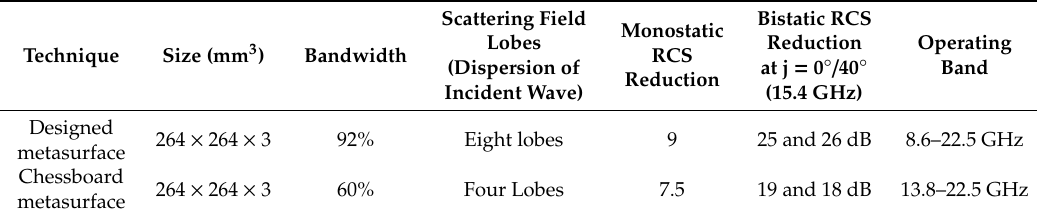
Table 2. Comparison between chessboard and coding di ff usion metasurface.